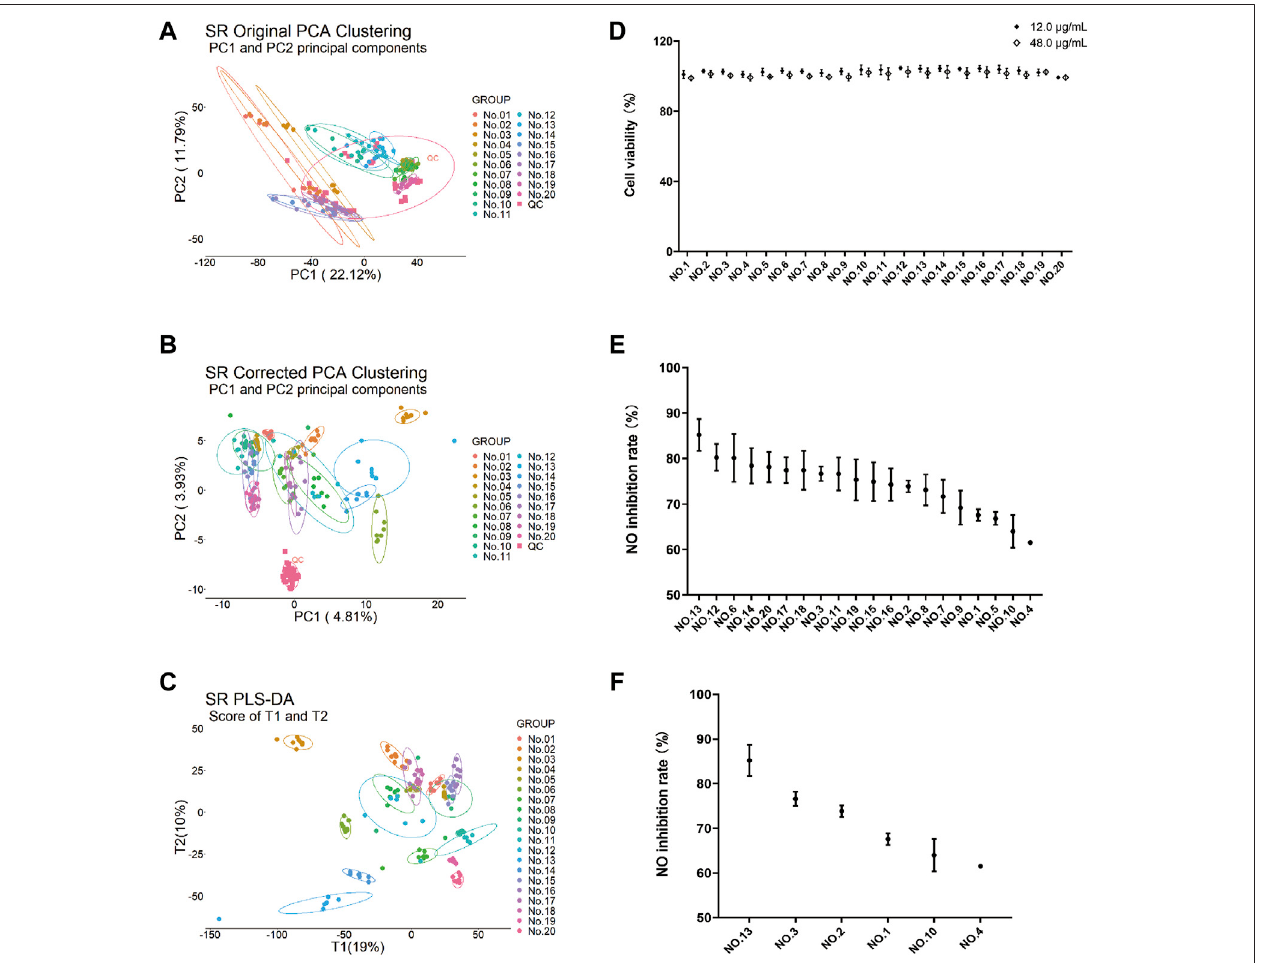
FIGURE 1| Plant metabolomics analysis and anti-in fl ammatory activity of20 batches of SR extracts. PCA of70% methanol extracts from 20batches ( n = 8) of SR before correction (A) and after correction (B) . (C) PLS-DA analysis of 70% methanol extracts from 20 batches of SR after correction. (D) Viability of Raw264.7 cells with 20batchesofSRextractsat12 μ g/mland48 μ g/ml.Eachvalueisexpressedasmean±SD( n =3). (E) Inhibitoryeffectsof70%methanolextractsfrom20batchesofSR at 48 μ g/ml on 1 µg/ml LPS-induced NO production in Raw264.7 cells. Each value is expressed as mean ± SD ( n = 3). (F) Inhibitory effects of 70% methanol extracts of 6 batches of SR with signi fi cant differences at 48 μ g/ml on LPS induced NO production in Raw264.7 cells. Each value is expressed as mean ± SD ( n = 3). Values are signi fi cantly different by Duncan ’ s multiple range test ( p < 0.05).